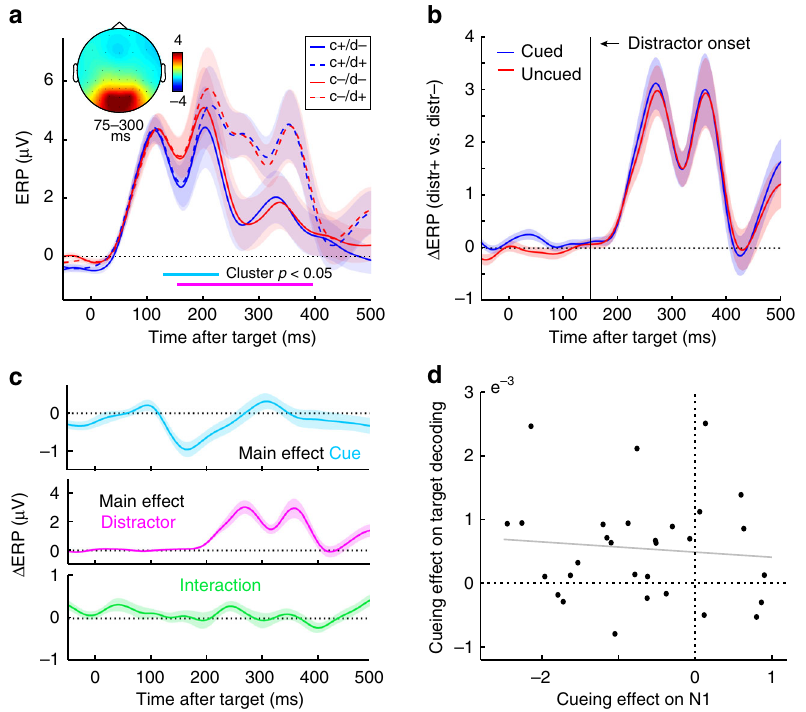
Fig. 5 Event-related potentials as a function of cue and distractor presence. a Time courses of the ERP in the selected eight most posterior channels as a function of cue and distractor presence (cf. Fig. 4a). Horizontal lines mark where the clusters of the contrasts that survived cluster-based permutation statistics were observed in the non-permutated data for the main effects of cue presence (light blue) and distractor presence (pink). No signi fi cant interaction effect was observed. Data are baseline corrected by a 250-pre-target baseline. Topography inset shows the visually evoked ERP component between 75 – 300 ms post-target (collapsed across all trial types). b Difference ERP for distractor-present vs. absent trials, as a function of cue presence. c Time courses of the main effects of cue and distractor presence, as well as their interaction. The interaction is expressed as the difference between cue present vs. absent trials in distractor-present vs. absent trials (cf. Fig. 4c). d Scatter plot showing absence of a correlation between the main cueing effect on the ERP (130 – 229 ms post-target), and the main cueing effect on target orientation decoding (118 to 248 ms post-target). Individual data